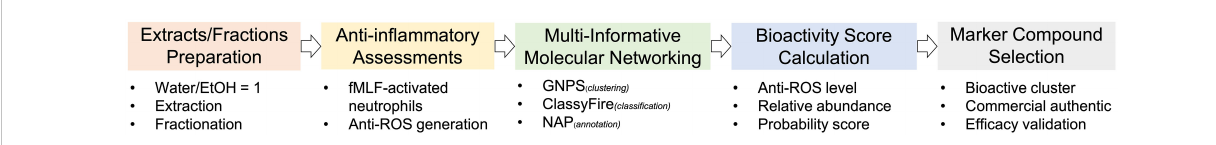
FIGURE 1 The multi-informative molecular networking (MIMN) platform for probing chemical markers of heat-clearing herbs